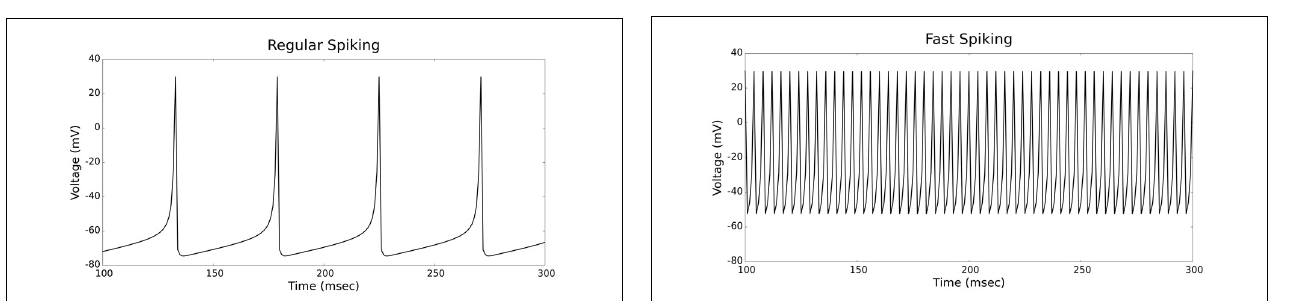
FIGURE 7 | IZH neuron model: fast spiking firing